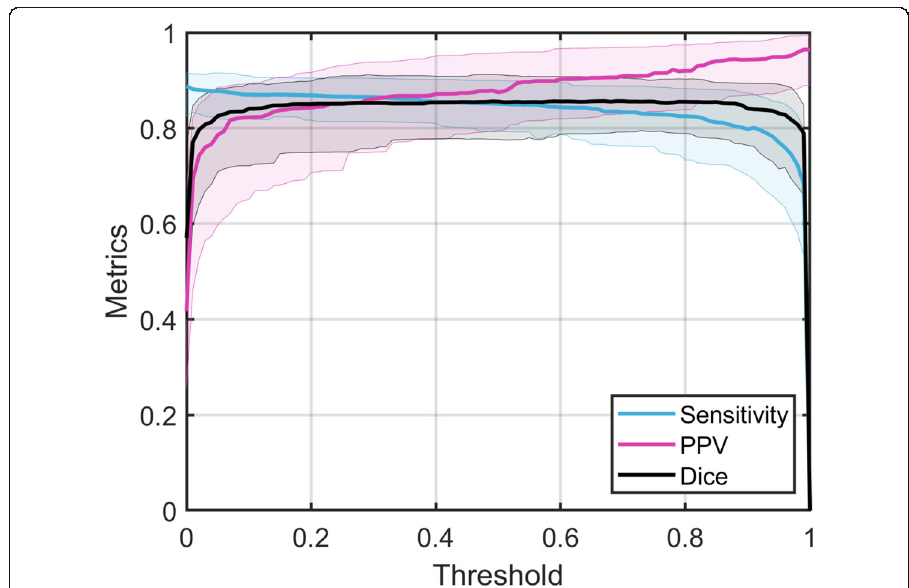
Fig. 2 Segmentation performance as a function of baseline 3CNN probability threshold. Solid lines show median value across the 100 patients, shaded areas show interquartile